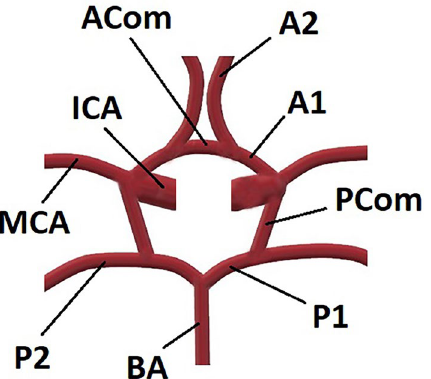
Figure 1. A schema will be used to present the different types of COW and to indicate the differences between the variances better ( Acom anterior communicating artery, PCom posterior communicating artery, P1 pre communicating segment of posterior cerebral artery, P2 post communicating segment of posterior cerebral artery, ICA internal carotid artery, A1 pre communicating segment of anterior cerebral artery, A2 post communicating segment of posterior cerebral artery, MCA middle cerebral